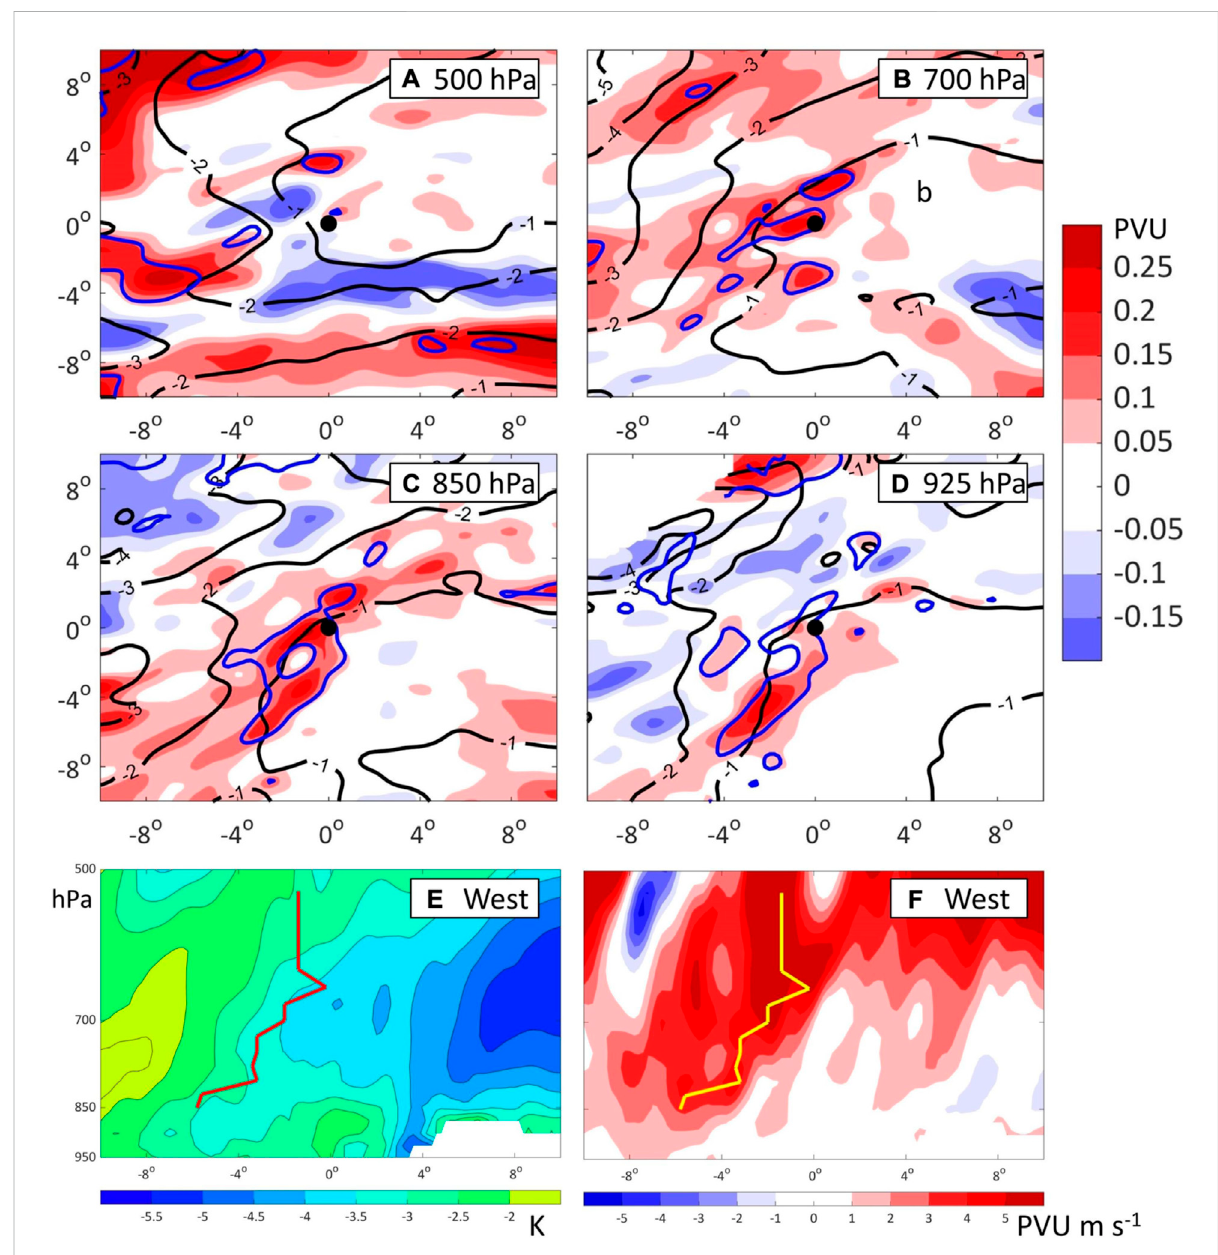
FIGURE 13 Differences in PV (shadings) and potential temperature (black contours; unit: K) between Exp-Ctrl and Exp-MT at different levels around the cyclone centers (A – D) , as well as differences in potential temperature (E) and uPV (F) at the west boundary. Blue lines in (A – D) show the